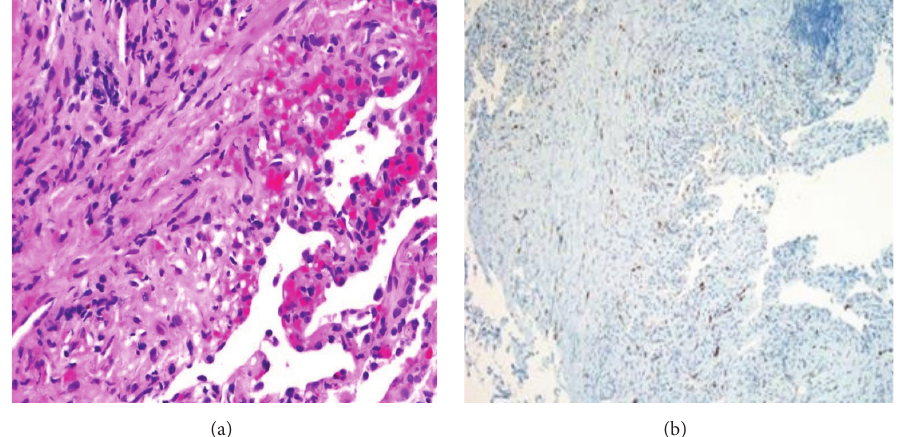
Figure 3: (a) Atypical spindle cell proliferation with slit-like vascular spaces, lymphoplasmacytic infiltrate, and extravasated red blood cells. (b) Nuclear HHV8 immunostain is expressed in the atypical spindle cell